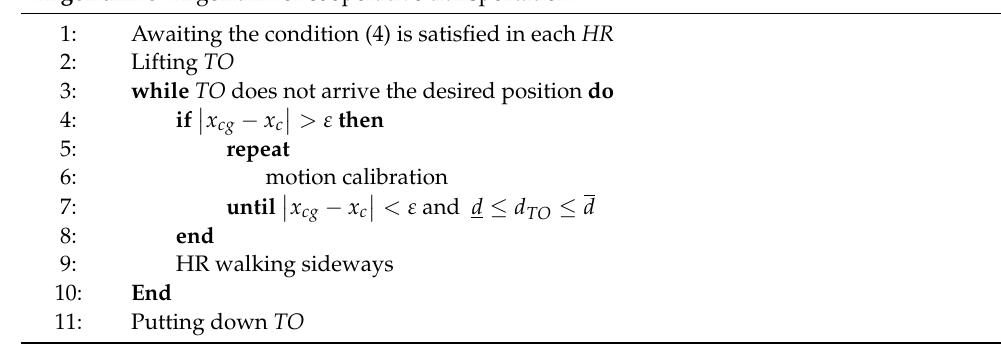
Algorithm 3 : Algorithm of cooperative